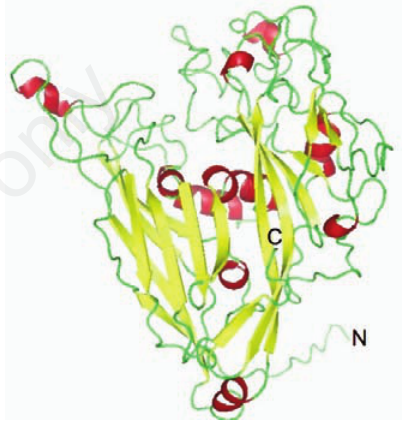
Figure 2. The three-dimensional structures of EhV99B1 Msjor Capsid Protein (MCP) predicted by the SWISS-MODEL (http://swissmodel.expasy.org/). The range between ASP-23 and GLN-42 is predicted to be transmembrane segments. Red: - helices; yellow: -sheets; green: loops. α β